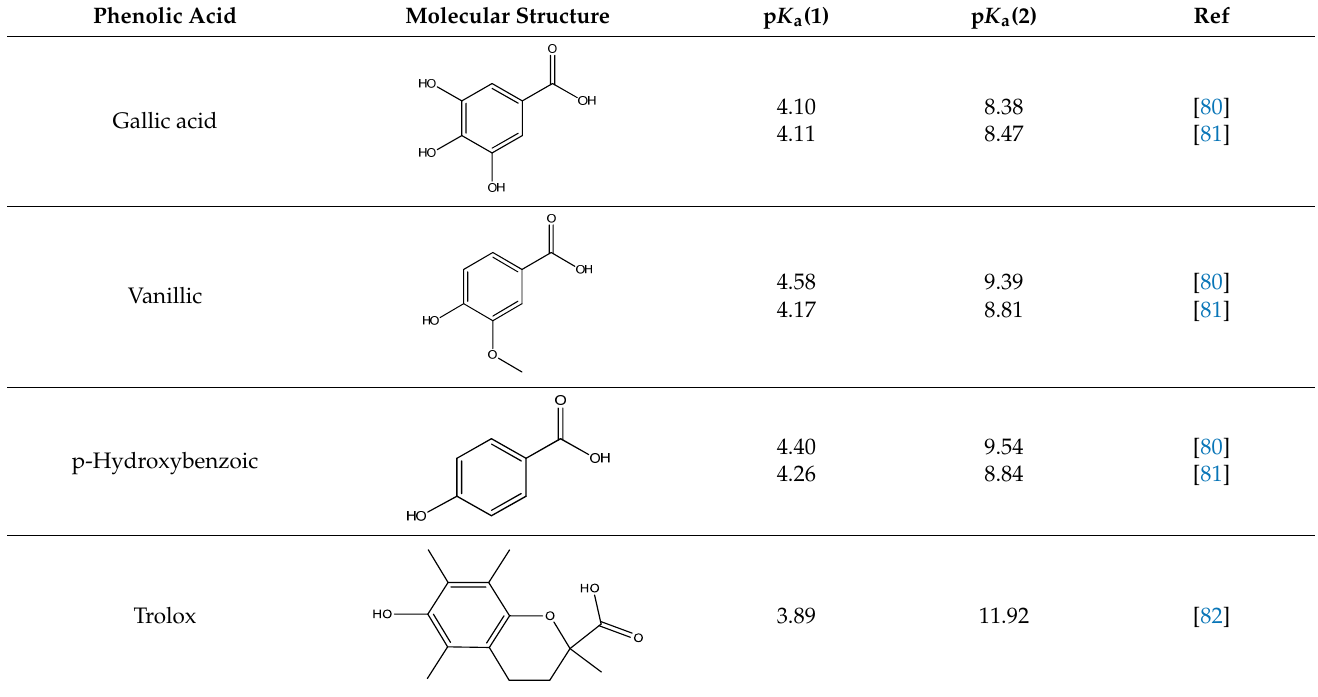
Equation (6) predicts that the variation of P WO (app) with the acidity is sigmoidal, as